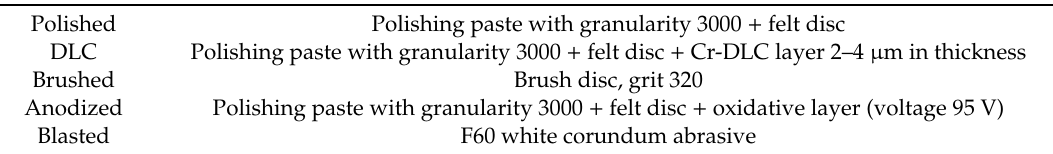
Table 1. Titanium surface treatment